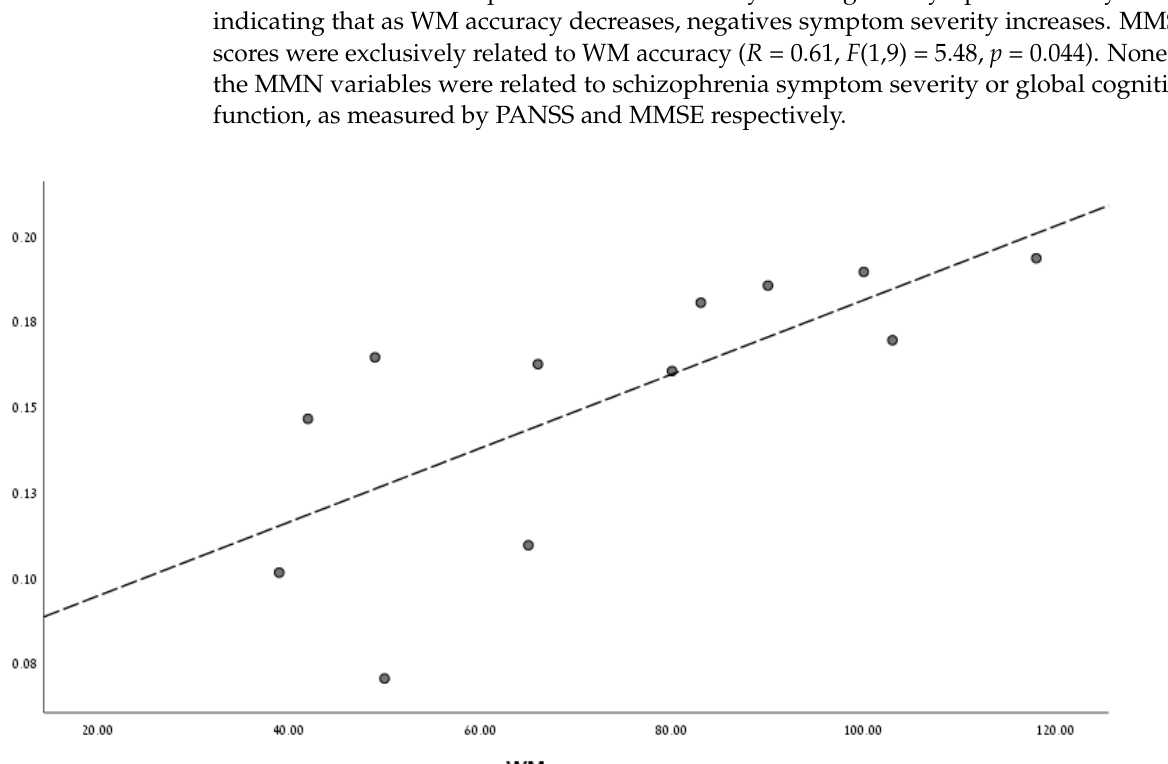
Figure 4. WM accuracy scores are related to negative symptom severity in the SZ group. The figure illustrates a significant relationship between WM accuracy and negative symptom severity in schizophrenia patients. The Y axis represents working memory (WM) accuracy; the maximum total accuracy score is 126 (number of hits). The X axis represents negative symptom severity scores ranging from a minimum score of 7 to a maximum score of 49.